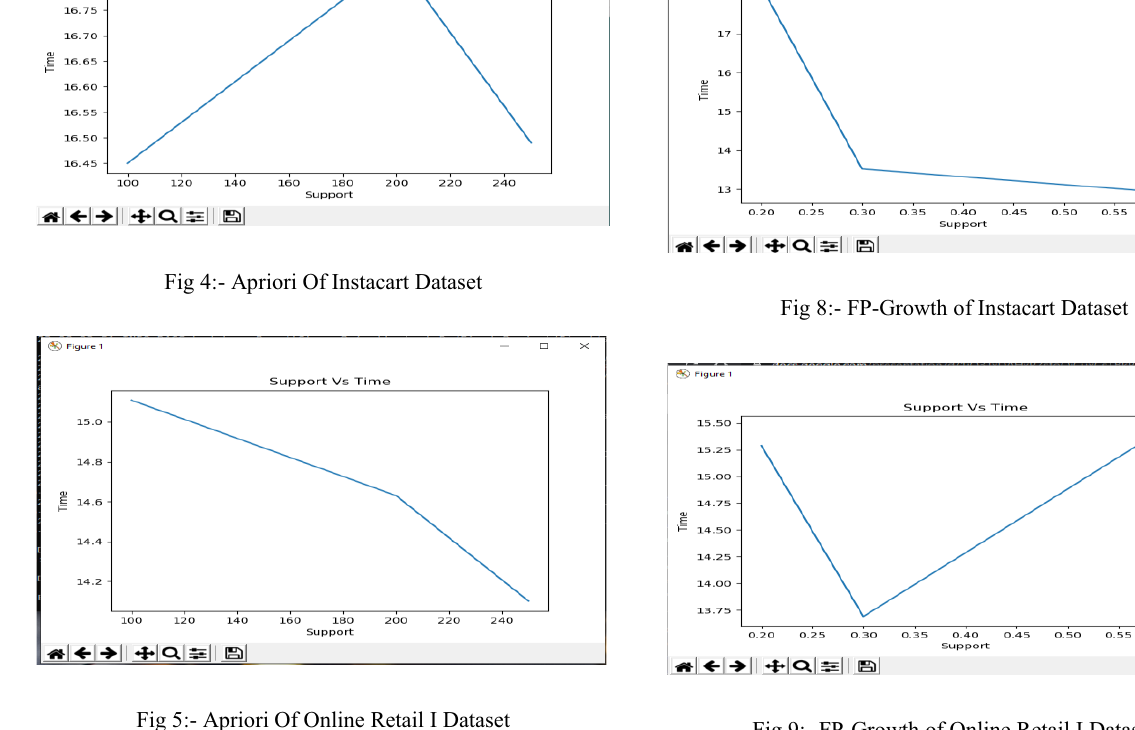
Fig 9:- FP-Growth of Online Retail I Dataset